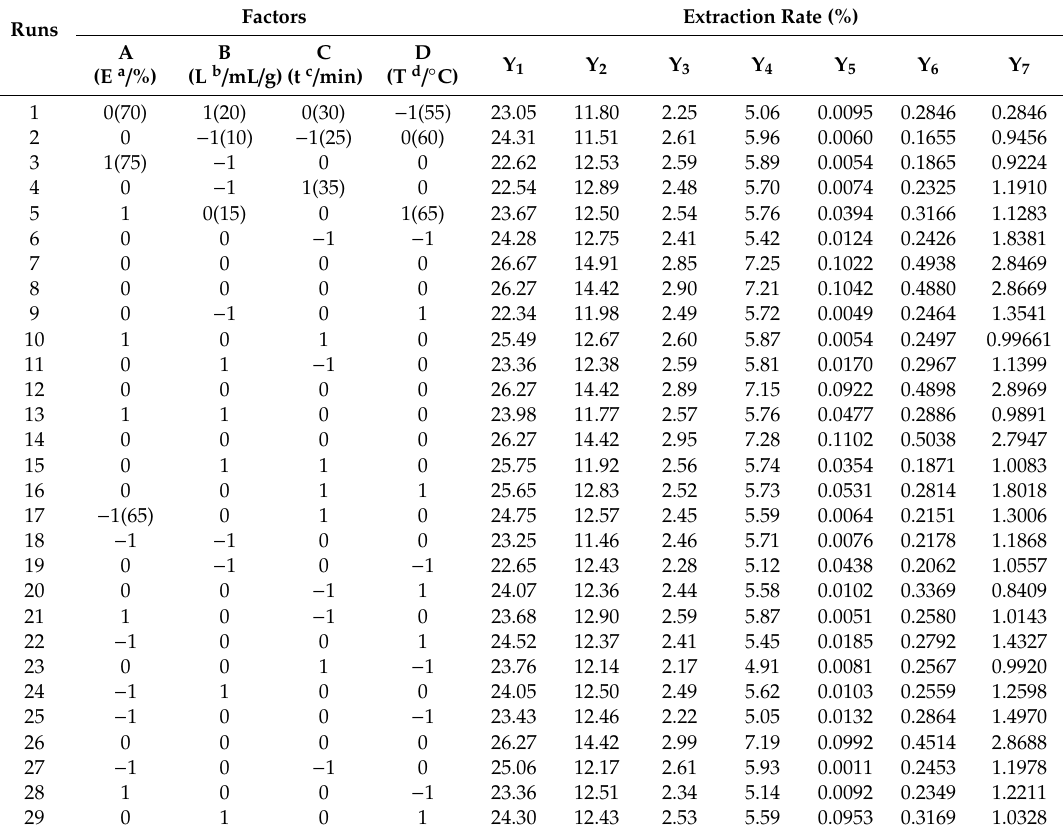
Table 5. Results of the Box–Behnken design (BBD) for the extraction rates of RU, NI, NA, KA, IS, QU, and the